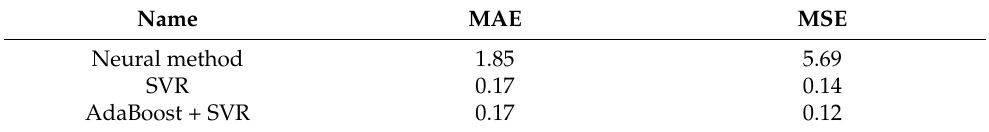
Table 5. Comparison of our SVM and AdaBoost + SVM results with the result from the multilayer